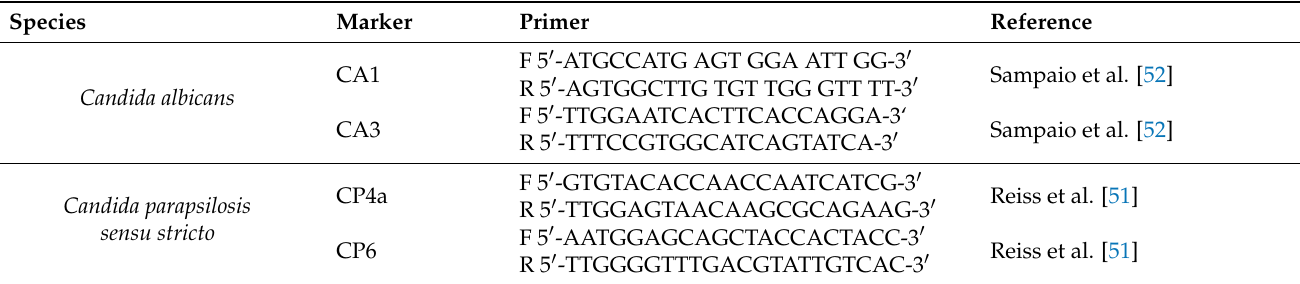
Table 5. Primers used for microsatellite sequences